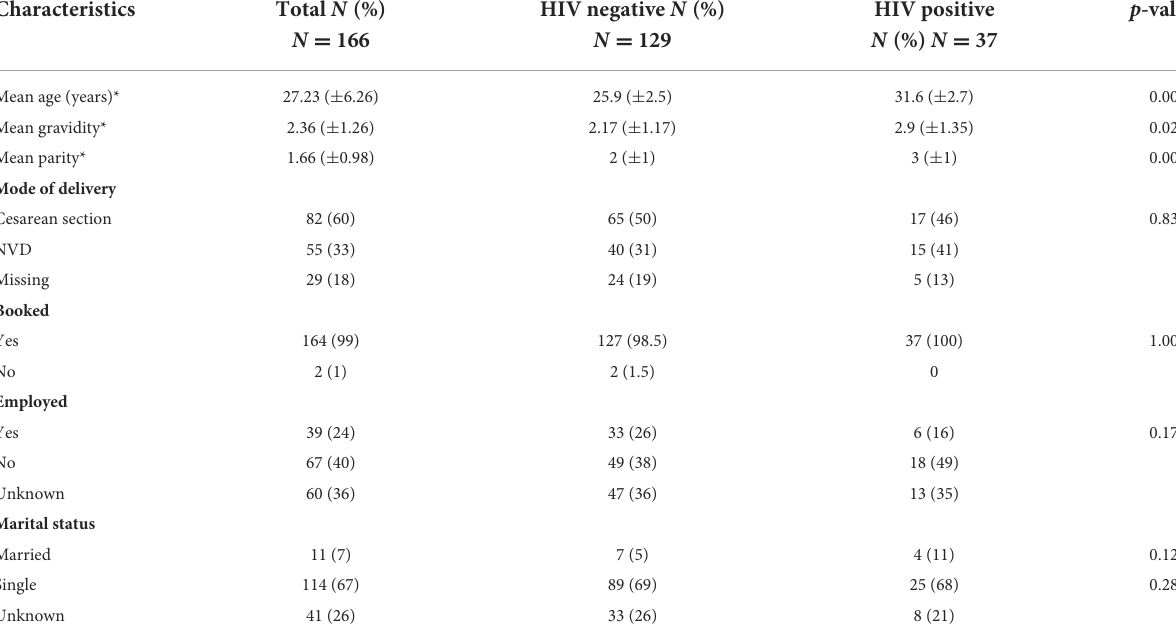
TABLE 1 Maternal demographics of neonates admitted to the KMC ward. Characteristics